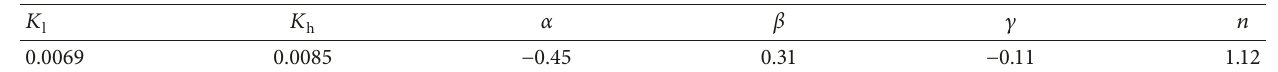
Figure 5: Rapid control prototypes of the proposed control method. (a) Schematic. (b) Table 1: Identified parameters of the Bouc–Wen model.